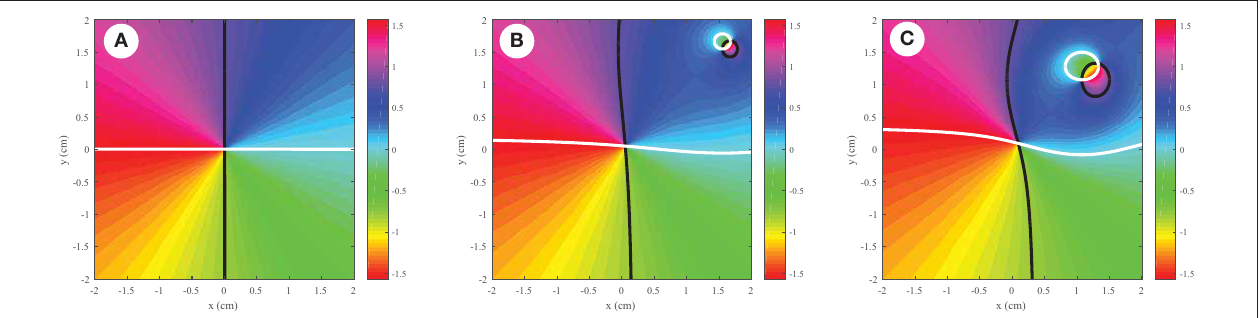
0.1 cm, (B) δ 0.5 cm, (C) δ 3 cm. Here = = =